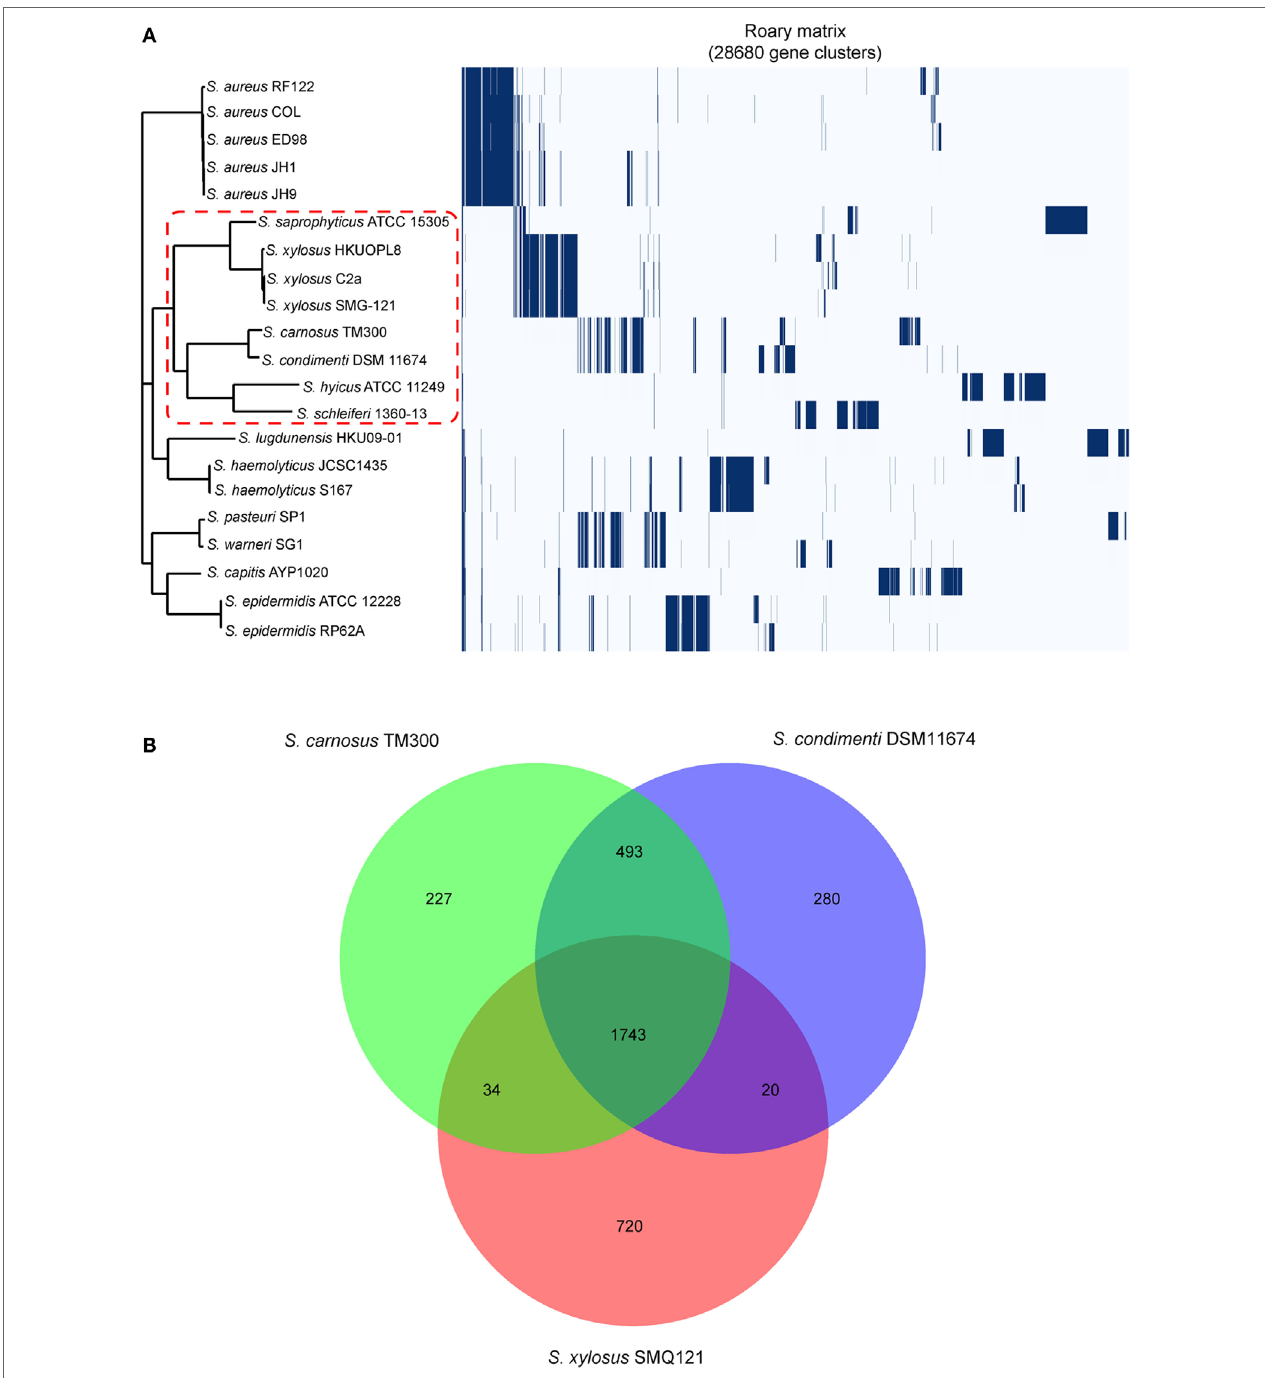
FIGURe 1 | Genomic comparison of the Staphylococcus condimenti DSM 11674 with other staphylococci. (a) Phylogenetic tree based on all core gene sequences of 21 staphylococci complete genomes. Multiple sequence alignments of concatenated core gene sequences were calculated within Roary pipeline. The branch of the members of the S. condimenti is delimited by a red dash line. The isolates used in this study include Staphylococcus schleiferi 1360-13 (CP009470), Staphylococcus epidermidis RP62A (CP000029), S. epidermidis ATCC 12228 (AE015929), Staphylococcus capitis AYP1020 (CP007601), Staphylococcus warneri SG1 (CP003668), Staphylococcus pasteuri SP1 (CP004014), Staphylococcus haemolyticus S167 (CP013911), S. haemolyticus JCSC1435 (AP006716), Staphylococcus lugdunensis HKU09-01 (CP001837), Staphylococcus hyicus (CP008747), S. condimenti DSM 11674 (CP015114), Staphylococcus carnosus TM300 (AM295250), Staphylococcus xylosus SMG-121 (CP008724), S. xylosus C2a (LN554884), S. xylosus HKUOPL8 (CP007208.1), Staphylococcus saprophyticus ATCC 15305 (AP008934), Staphylococcus aureus RF122 (AJ938182), S. aureus COL (CP000046), S. aureus ED98 (CP001781), S. aureus JH1 (CP000736), and S. aureus JH9 (CP000703). (B) Core genome analysis of S. condimenti DSM 11674, S. carnosus TM300, and S. xylosus SMG-121. Numbers inside the Venn diagrams indicate the number of genes found to be shared among the indicated genomes.